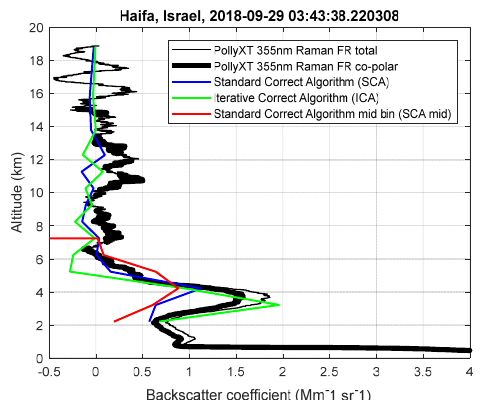
Fig. 4: Comparison of PollyXT at Haifa, Israel during Aeolus overpass on 29 September 2018.